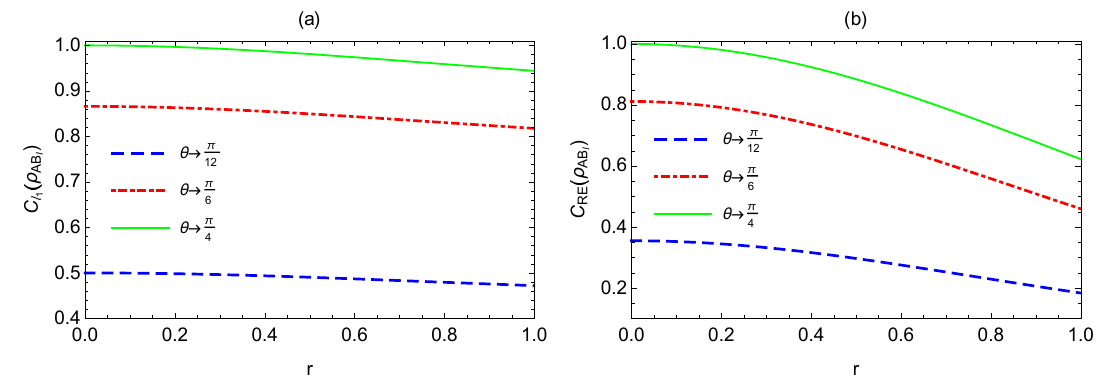
( ρ AB ) and C RE ( ρ AB 1 I